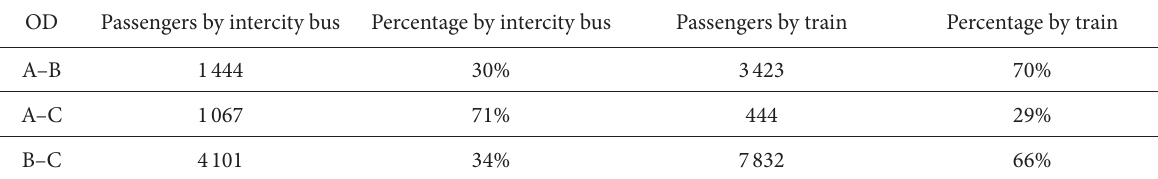
Table 4. Results of mode